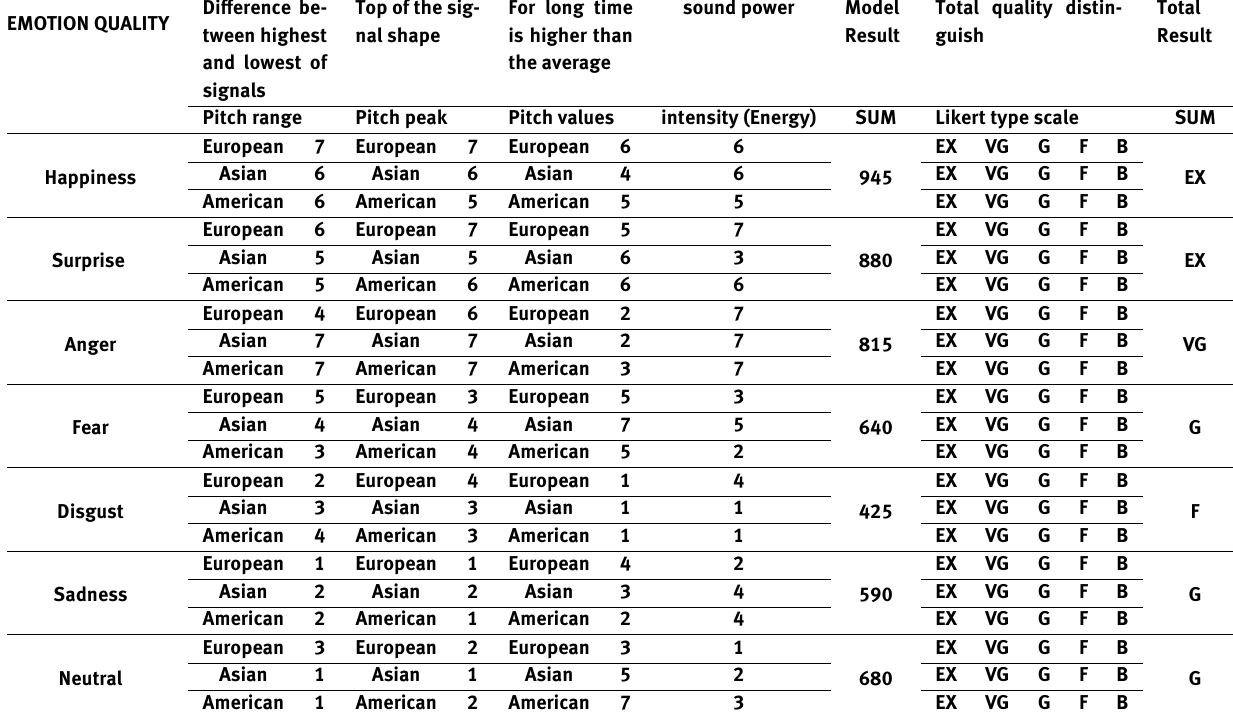
Table 2. Likert type scale for emotion recognition.